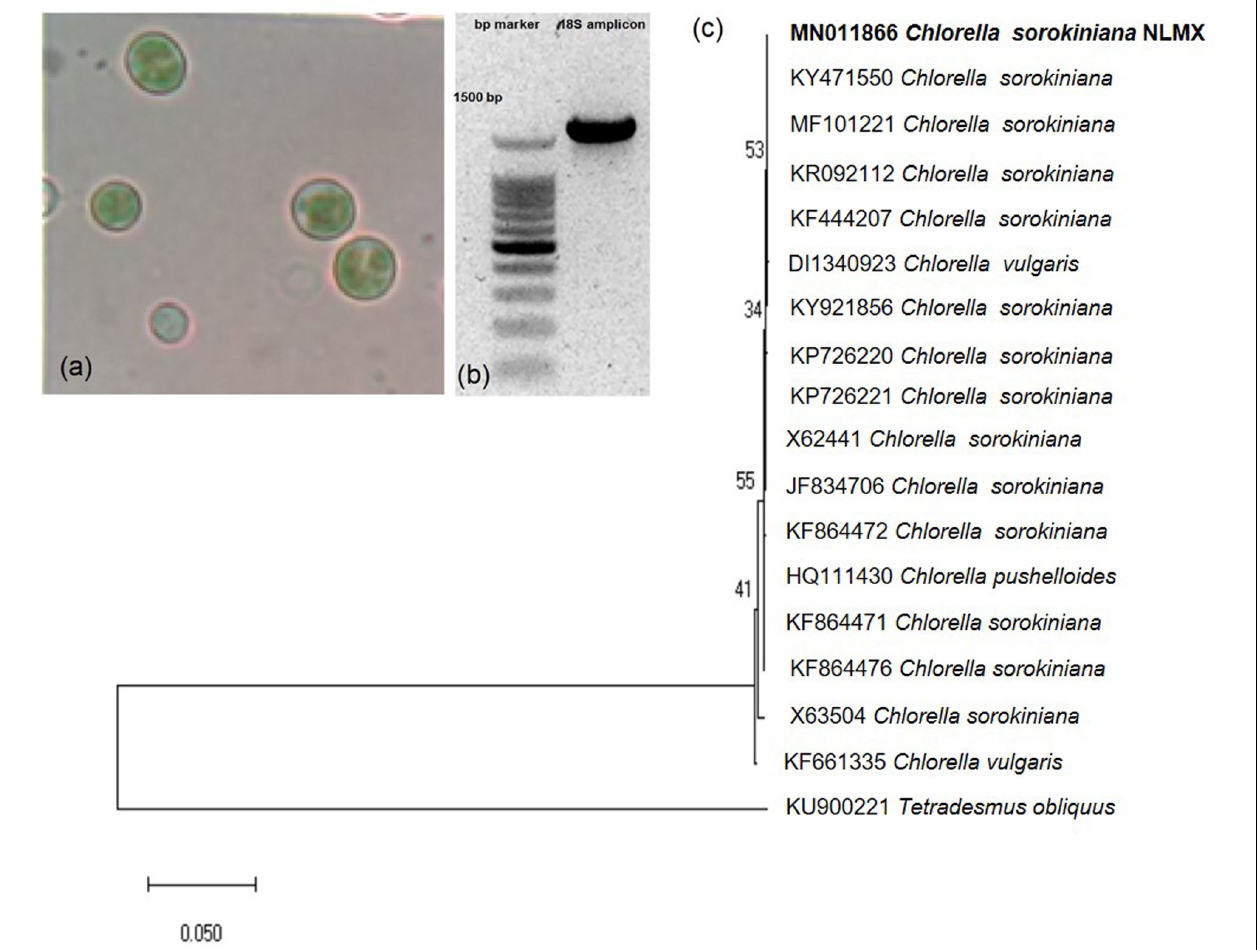
FIGURE 1 | Microalgae phenotypic and molecular characterization. (a) Microscopic characteristics of Chlorella spp. (b) Partial amplification of Chlorella spp. 18S ribosomal RNA gene, (c) Phylogenetic analysis of 18S ribosomal RNA amplicon which clustered with previously reported Chlorella sorokiniana sequences. The evolutionary history was inferred by using the Maximum Likelihood method and Tamura-Nei model. The tree is drawn to scale, with branch lengths measured in the number of substitutions per site. This analysis involved 18 nucleotide sequences. There were 1,596 positions in the final dataset. Evolutionary analyses were conducted in MEGA X (Kumar et al., 2018).